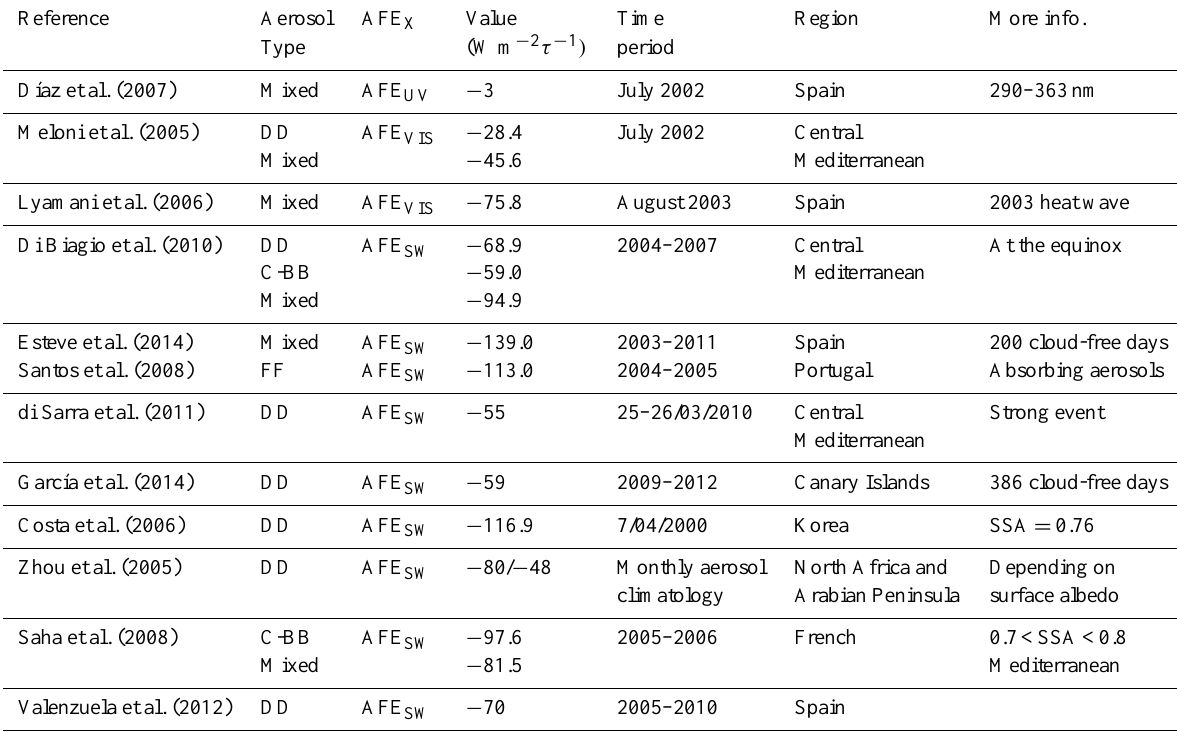
Table 4. Daily forcing efficiencies at the surface by previous studies. Legend: desert dust (DD), continental-biomass burning (C-BB), and forest fires (FF).